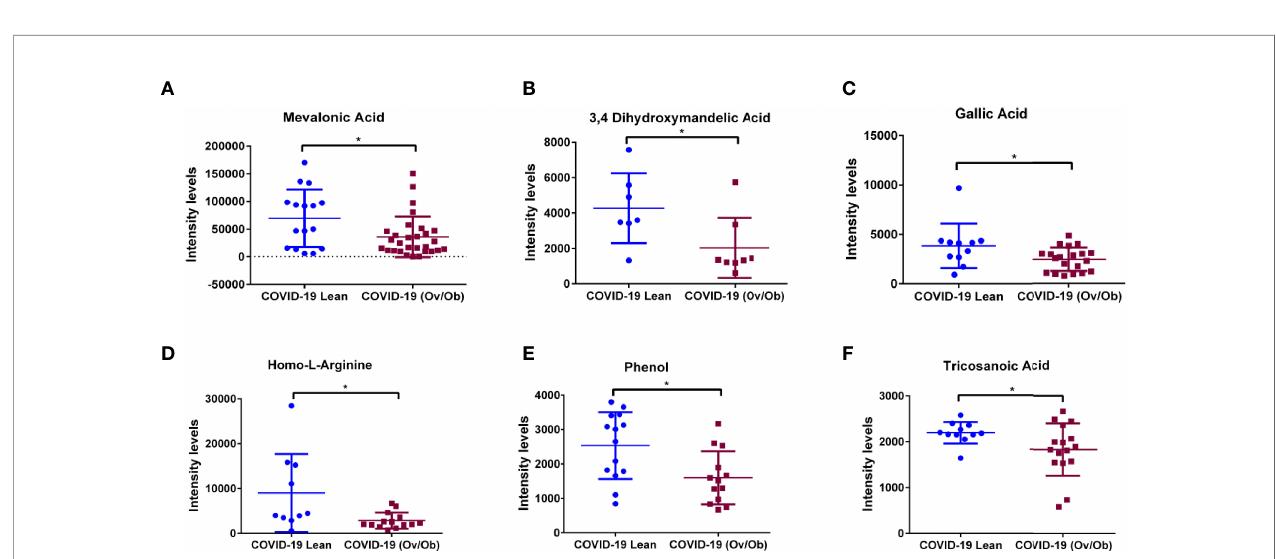
FIGURE 4 | Downregulation of plasma metabolites as markers of COVID-19 health complications in obese patients. Plasma levels of (A) Mevalonic acid, (B) 3,4- Dihydroxymandelic acid, (C) Gallic acid, (D) Homo-L-Arginine, (E) Phenol, and (F) Tricosanoic acid displayed signi fi cantly lower levels in COVID-19 overweight-obese patients compared to COVID-19 lean patients. Analysis was performed using Mann Whitney t -test with or without Welch ’ s correction test; * P < 0.05.